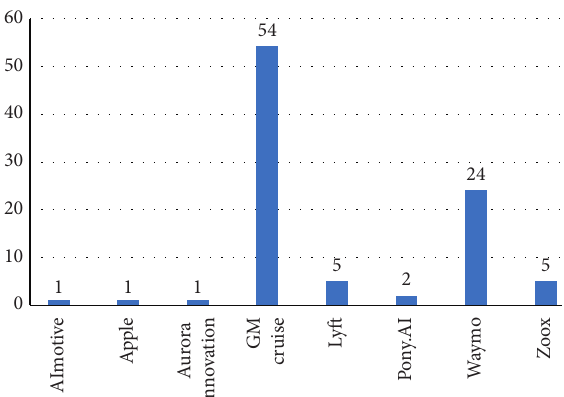
Figure 2: AVs crashes of different